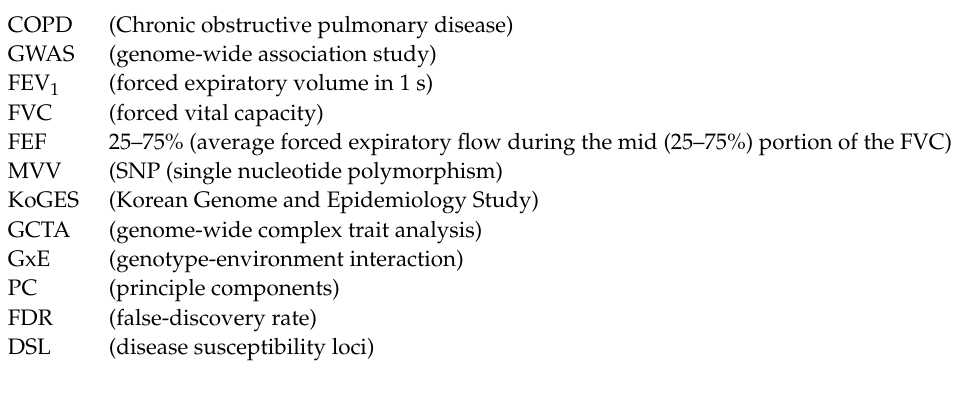
for lung function; Table S13: Genome-wide association analysis results of annual change rate ( ˆ β 1 ) for post-FEV 1 /FVC. Top 40 variants are listed after clumping; Table S14: The fixed effects